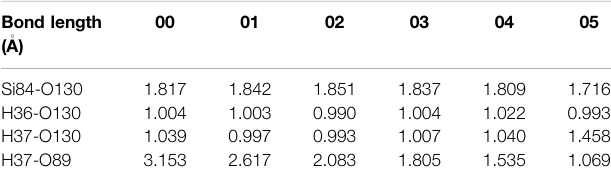
TABLE 4 | Changes in bond length for the reaction of H 2 O and P b1 defect with AOD con fi guration at random position 1. Bond length ( (cid:1) A)